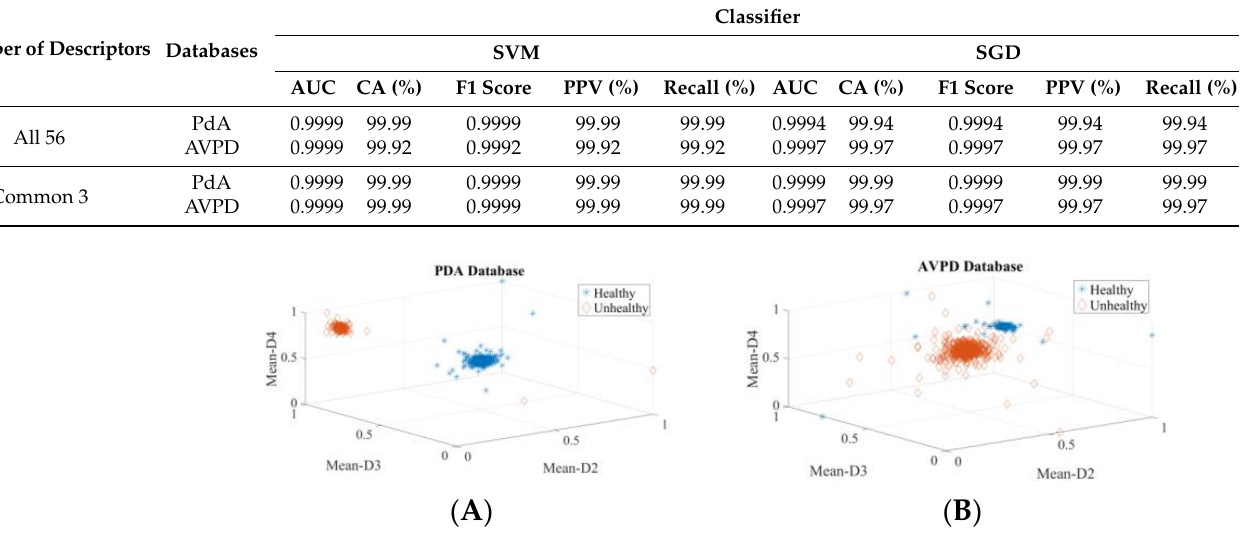
Figure 12. Three-dimensional scatter plots for detection process with full PdA and AVPD datasets: ( A ) Three-dimensional scatter plots for detection process with full PdA dataset, ( B ) Three-dimensional scatter plots for detection process with AVPD